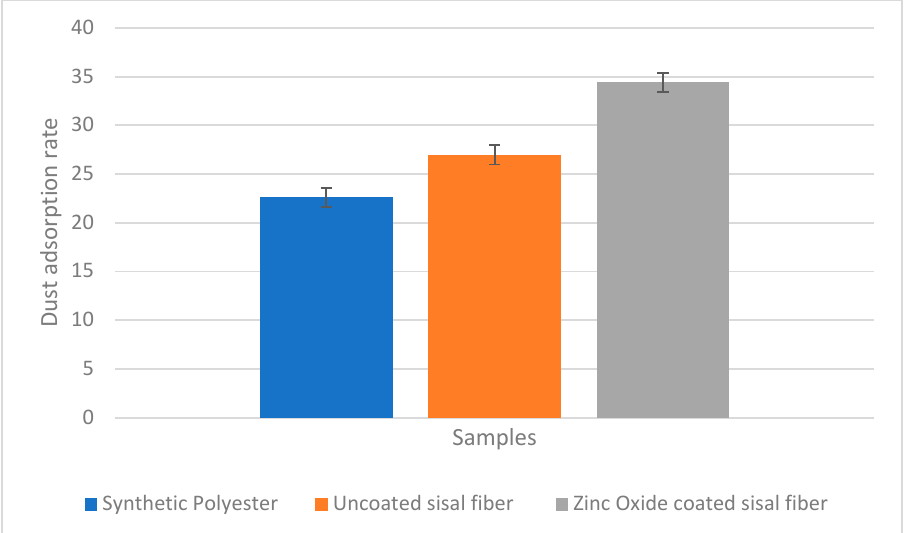
Figure 10. Dust adsorption rate of samples.